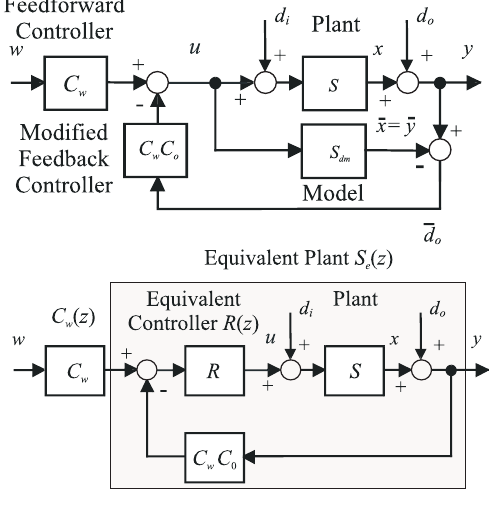
Figure 9. Impact of the disturbance feedforward on the equivalent